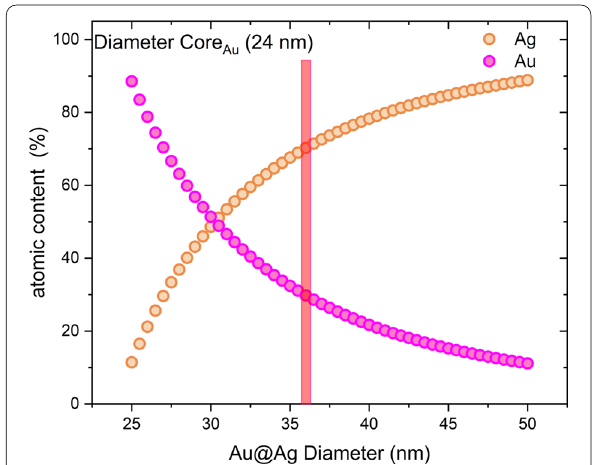
Fig. 7 Variations of atomic content percentage versus increase thickness shell, where diameter AuNPs (24 nm) was kept constant